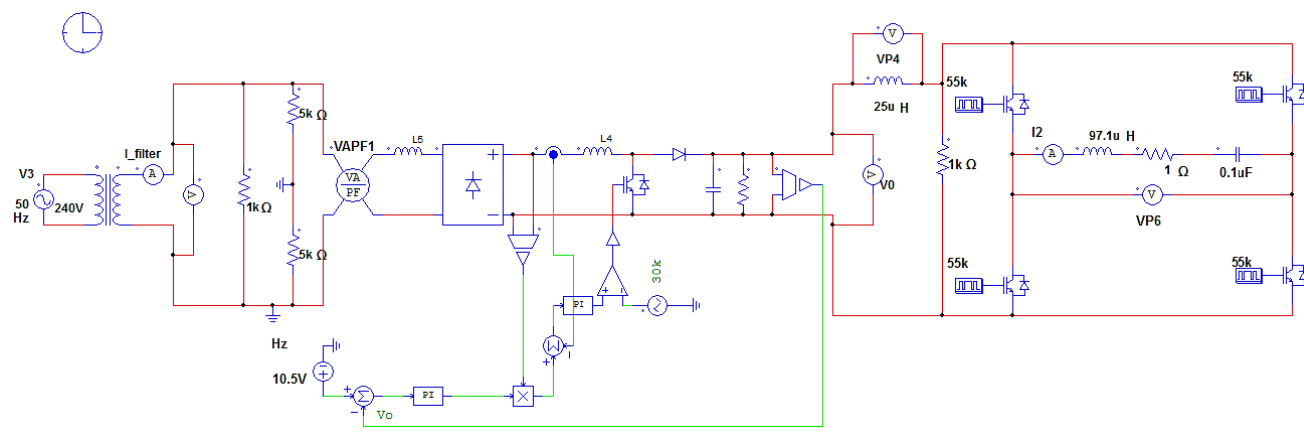
Figure 6. Simulation diagram of IH system with Boost